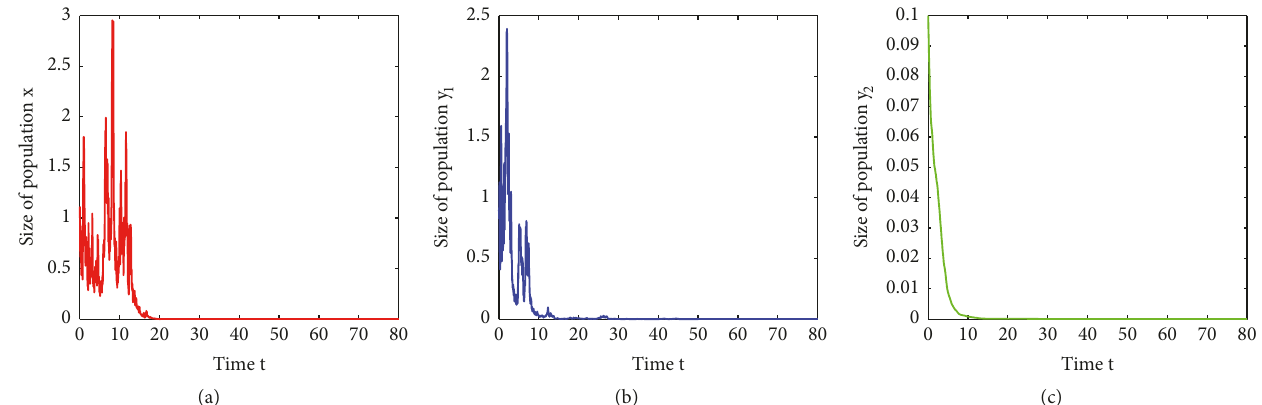
Figure 2: Numerical simulation of the solution of model (6). The parameters of model (6) are 𝑎 = 0.3 , 𝑏 = 0.15 , 𝑐 = 0.2 , 𝜂 = 0.2 , 𝑑 = 0.3 , ̂𝑒 = 0.15 , 𝑓 = 0.15 , 𝛿 = 0.2 , 𝑔 = 0.5 , 𝜎 2